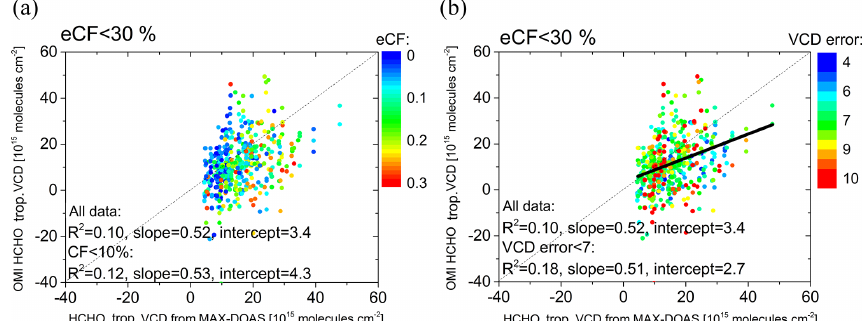
Figure 6. (a) HCHO tropospheric VCDs for OMI pixels for eCF<30% are plotted against those derived from MAX-DOAS observations with the colour map of eCF; the linear regression parameters are acquired for eCF<30% and for eCF<10%, respectively. (b) Scatter plots are same as in (a) , but with the colour map of VCD fit error; linear regression parameters are acquired for all data and for VCD fit error <7 × 10 15 moleculescm − 2